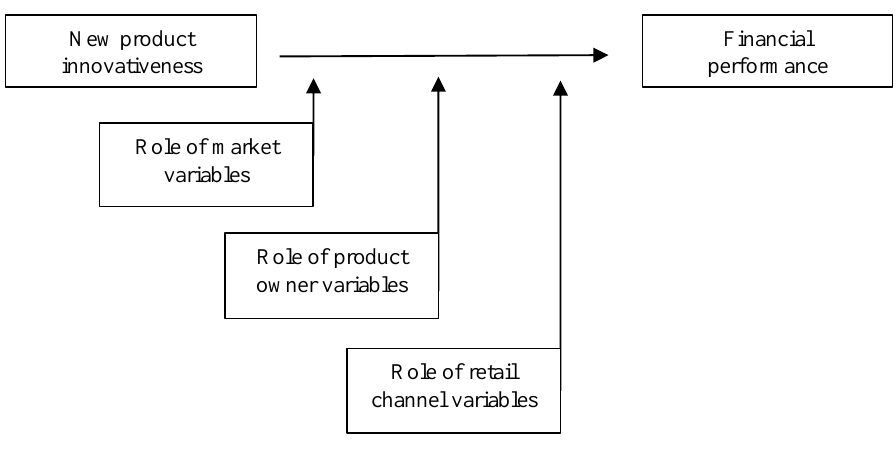
Fig. 1 . Conceptual